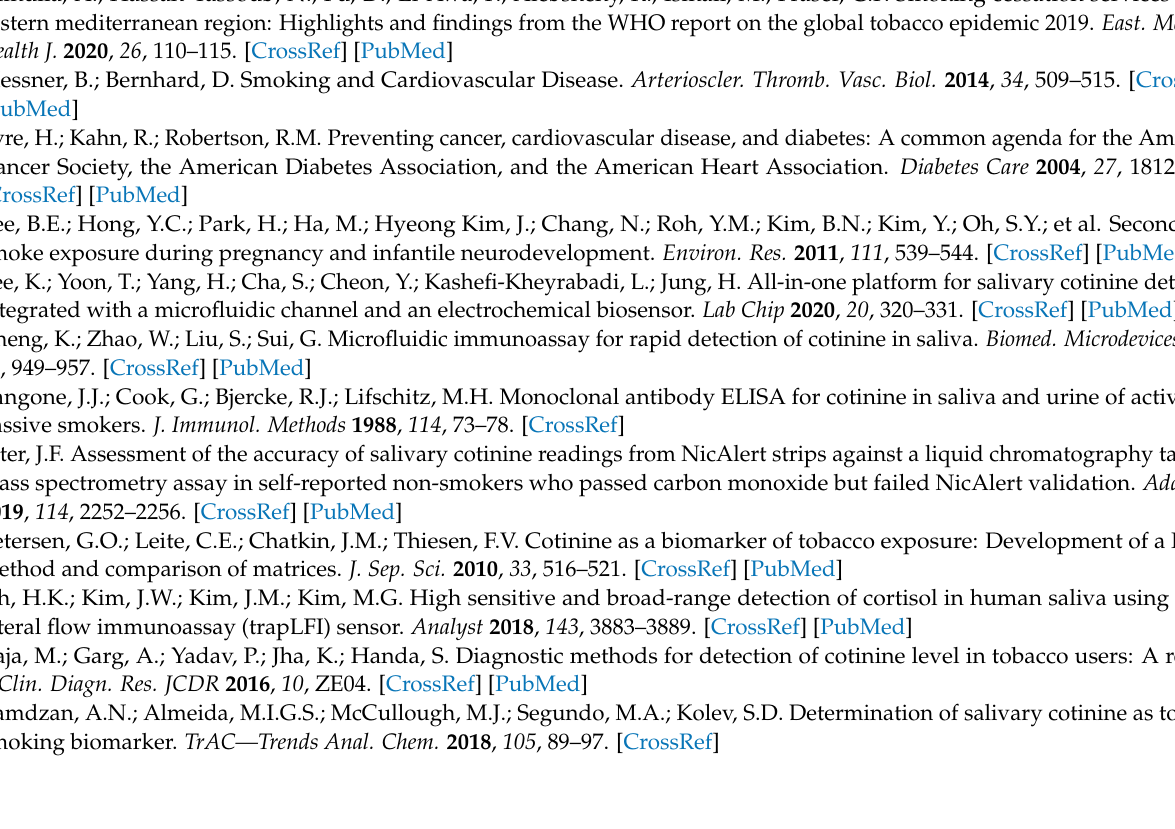
the concentration of anti-cotinine antibody in the gap-LFIA. ( A ) 12.5 ng/mL, ( B ) 25 ng/mL, and ( C ) 50 ng/mL of the anti-cotinine antibody. Figure S3: Comparison of the intensity of the gap-LFIA with 25 ng/mL cotinine antibody by the concentration of AuNP-secondary Ab conjugates without cotinine. Figure S4: Cotinine ELISA test by spiked in saliva in the cotinine concentration range of smokers and